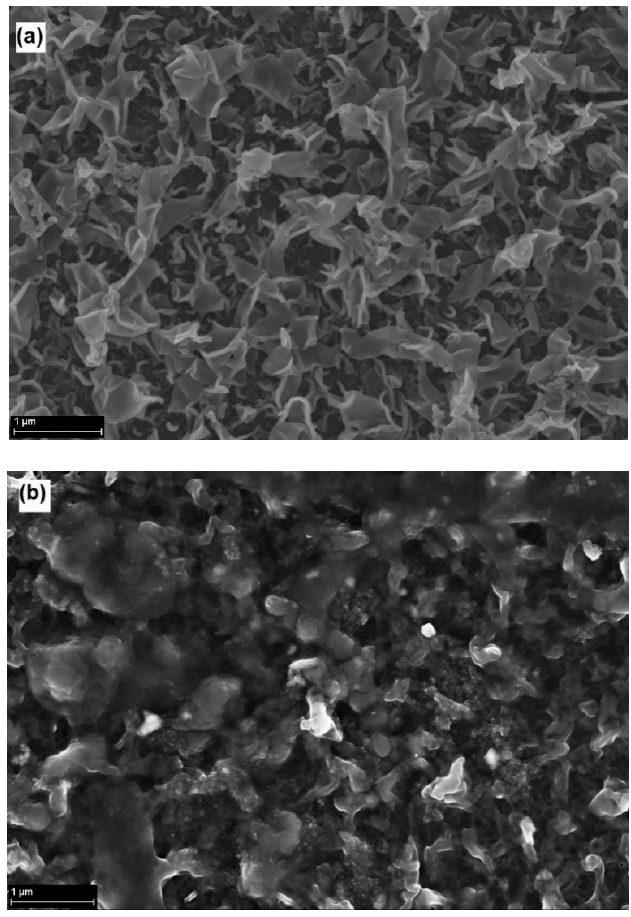
Figure 4. SEM images of the pristine ESPA-1 membrane ( a ), and the membrane taken from modified ESPA1-2521 module ( b ). The modification conditions were as follows: 2 mM GMA with addition of 0.045 mM Triton (0.5 h).